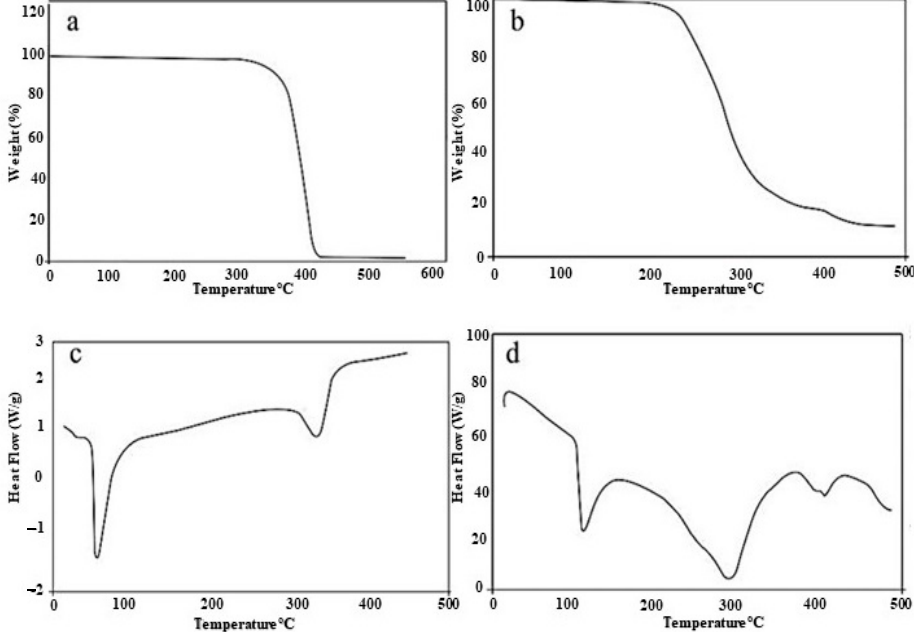
Figure 3. ( a ) TGA of PEG-8000. ( b ) TGA of formulation. ( c ) DSC of PEG-8000. ( d ) DSC of formulation.